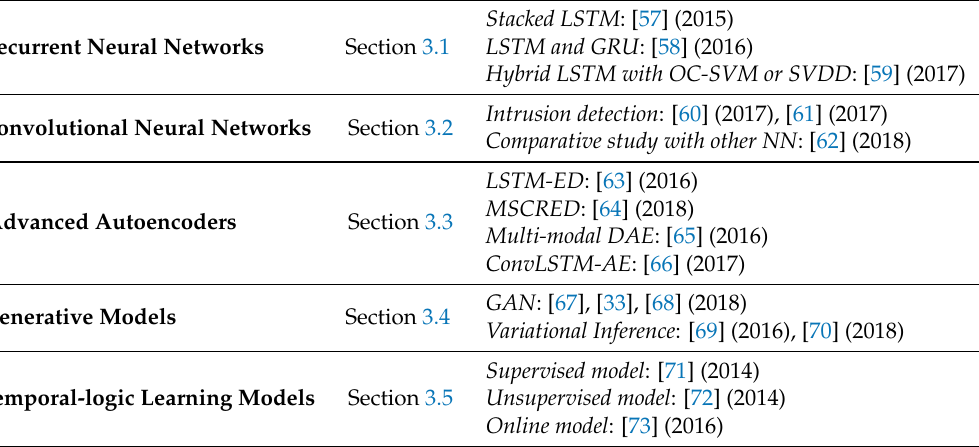
Table 1. Recent Bibliography in Anomaly